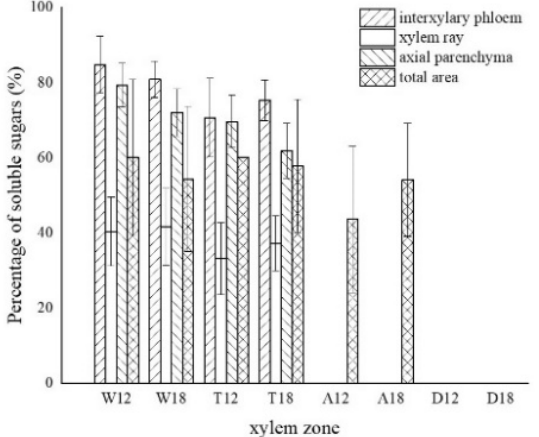
Figure 9. Statistics of color development of soluble sugar in xylem parenchyma cells. W—white zone; T—transition zone; A—agarwood zone; D—decay zone; 12—inoculated for 12 months; 18— inoculated for 18 months.